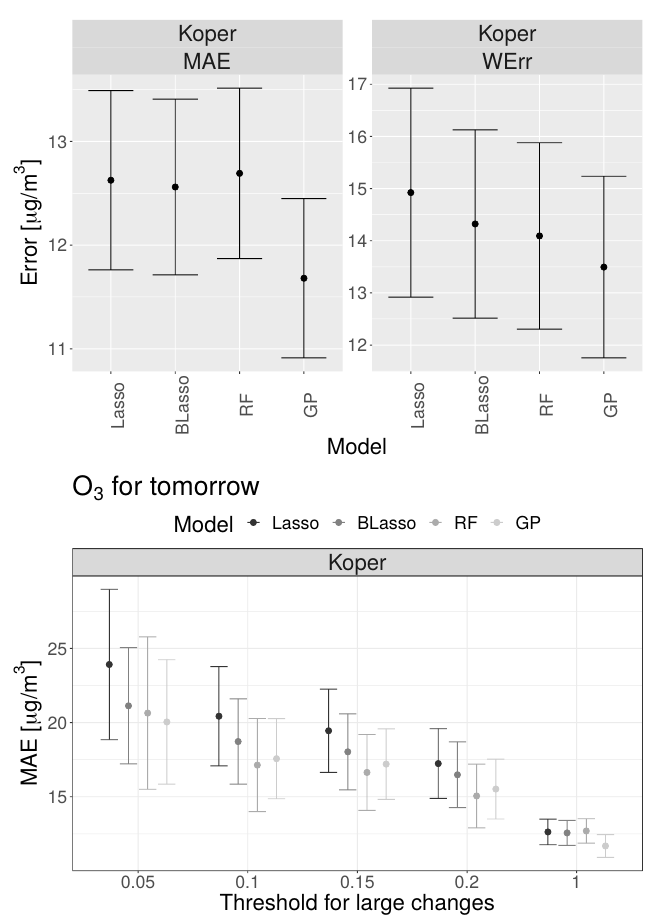
Figure 8. The top left figure shows MAE for different models for O 3 prediction for the following day in Koper, while the top right Figure shows WErr for the same models. The lower figure shows MEA for different ∆ C(2